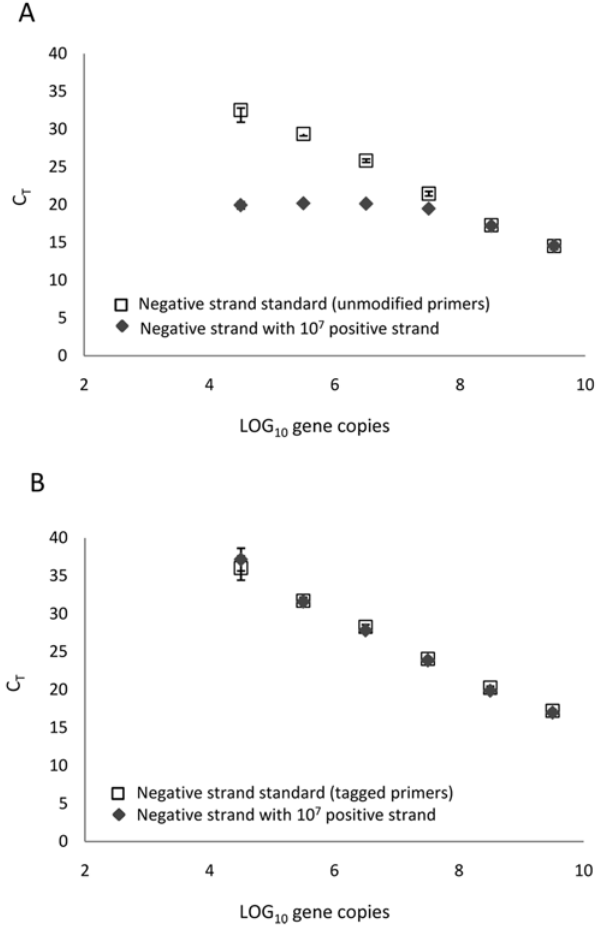
Figure 1. Detection of ONNV RNA with ssqPCR assays using unmodified or tagged primer systems. Quantification of ONNV ( 2 ) strand RNA with a ssqPCR assay using unmodified primers (A), or a tagged primer system (B) produces significantly different values ( P , 0.001). Amplification of cDNAs generated in an unprimed RT reaction with unmodified ONNV-specific primers (A).